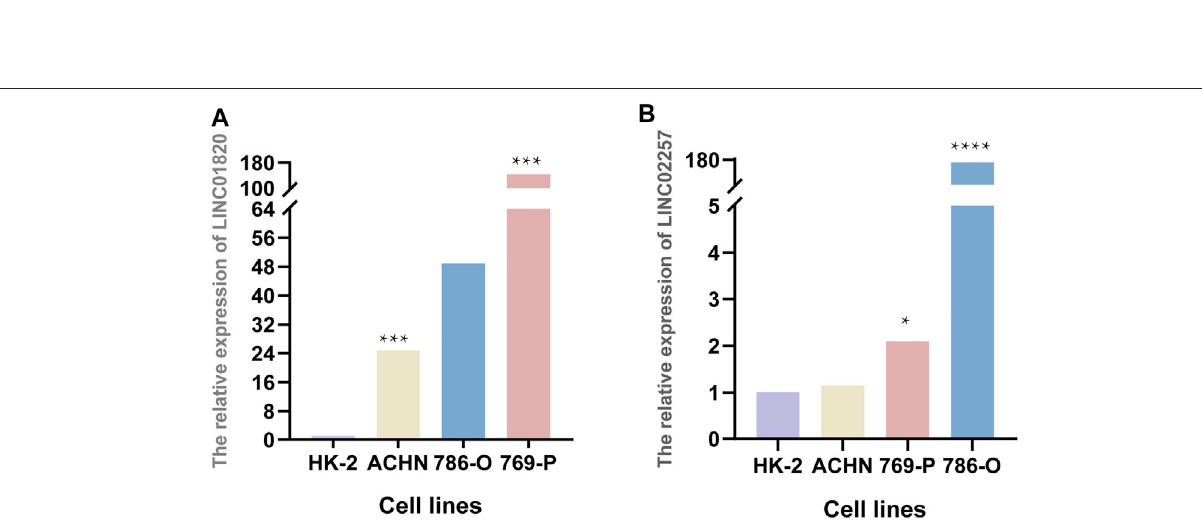
Frontiers in Molecular Biosciences |